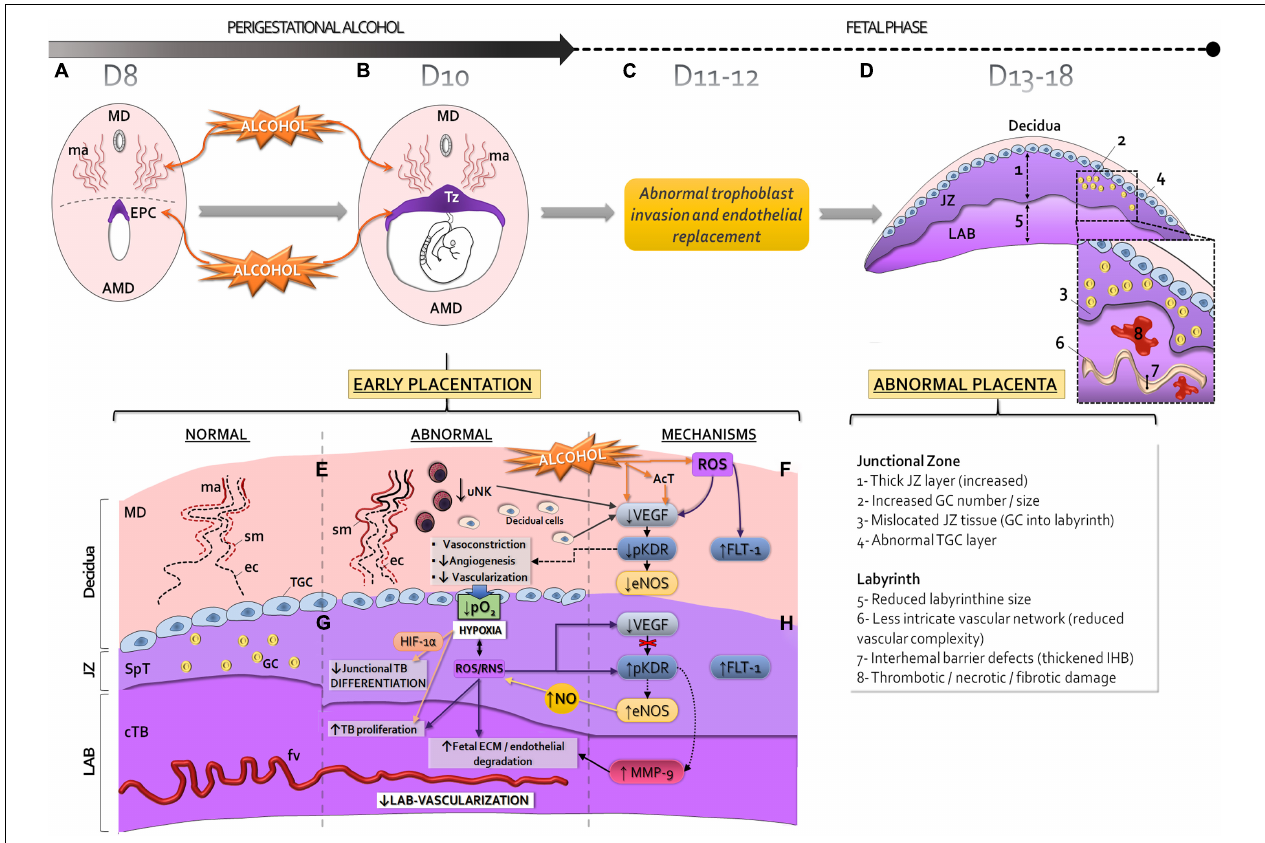
FIGURE 2 | Proposed mechanisms of abnormal early placentation and vascularization and long-term impact to placenta produced by perigestational alcohol consumption, in the mouse model. Perigestational alcohol (OH) intake up to gastrulation-organogenesis [day 8 (D8) (A) and 10 (D10) (B) , disrupts the maternal spiral artery (ma) remodeling of mesometrial decidua (MD), and alters the ectoplacental cone (EPC) (A) and subsequent development of trophoblastic zone (Tz) of the early placenta (B) . Consequently, after cessation of alcohol ingestion (day 11, D11), abnormal trophoblast invasion and endothelial replacement may occur (C) , leading to abnormal structure and function of the placenta at term (D) . The placental abnormalities can be originated in altered angiogenesis-vascularization of decidual-trophoblastic tissues (E,G) during perigestational alcohol exposure (B) . Alcohol and/or its metabolites [acetaldehyde, AcT, reactive oxygen species (ROS)] impact on the early placentation processes, including changes in uNK cells. Consequently, diminished junctional trophoblast differentiation and low labyrinthine growth and vascularization can occur (G) . The decidual-trophoblastic abnormalities can be associated with altered endothelial nitric oxide synthase (eNOS)